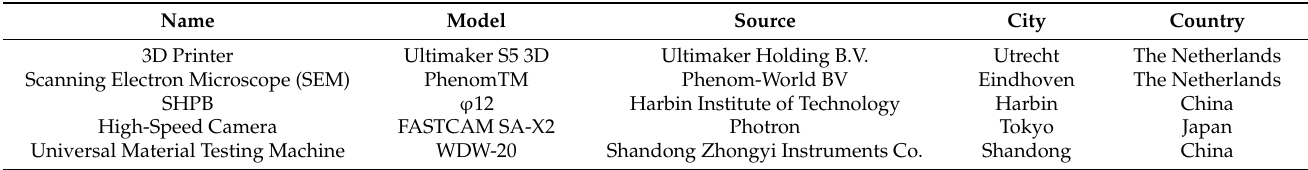
Table 3. Experimental equipment.